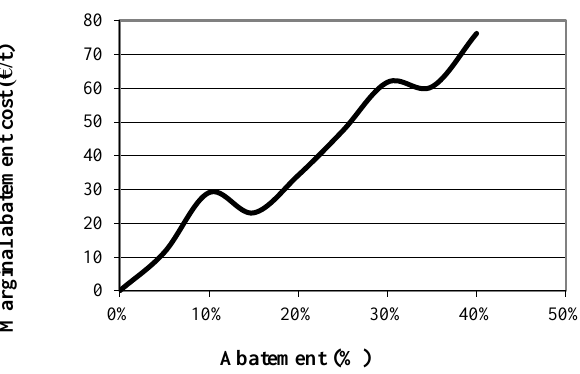
Figure 3. Marginal abatement cost curve of the extensive farm.